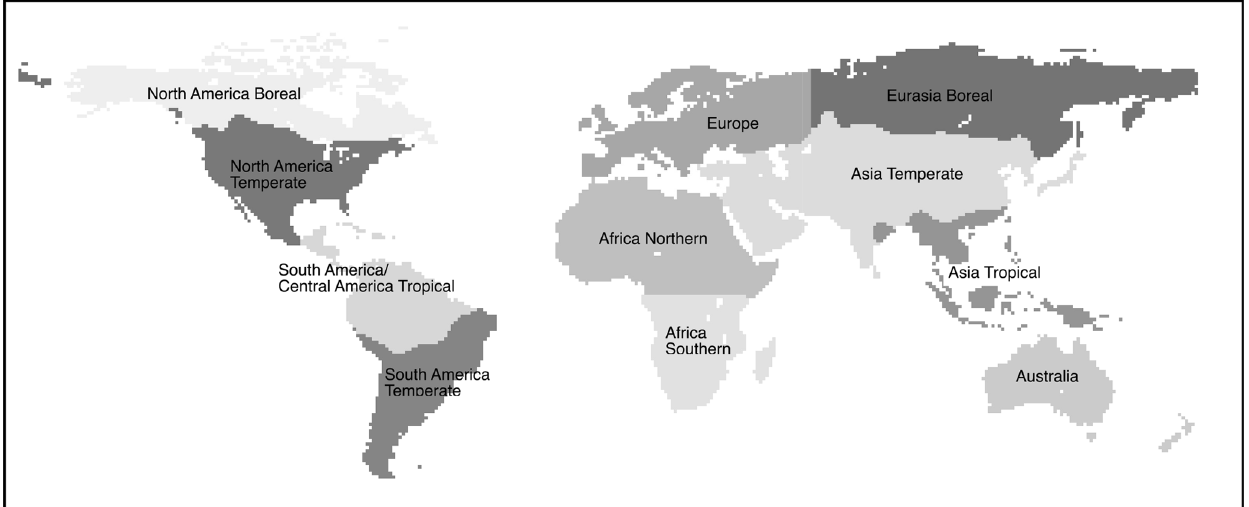
Figure 2. TransCom region